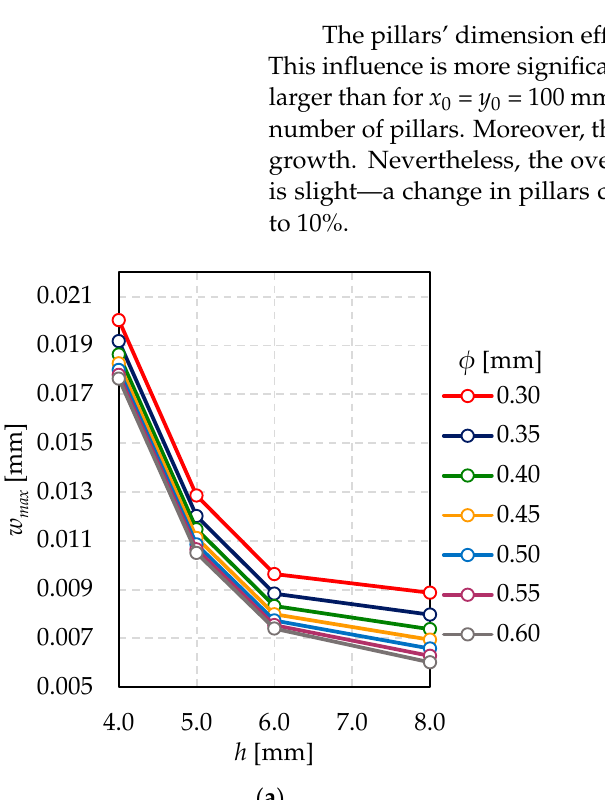
Figure 10. Shapes of the ( a ) bottom and ( b ) top glass panes deformations for x 0 = y 0 = 50 mm as well as ( c ) bottom and ( d ) top glass panes for x 0 = y 0 = 100 mm.